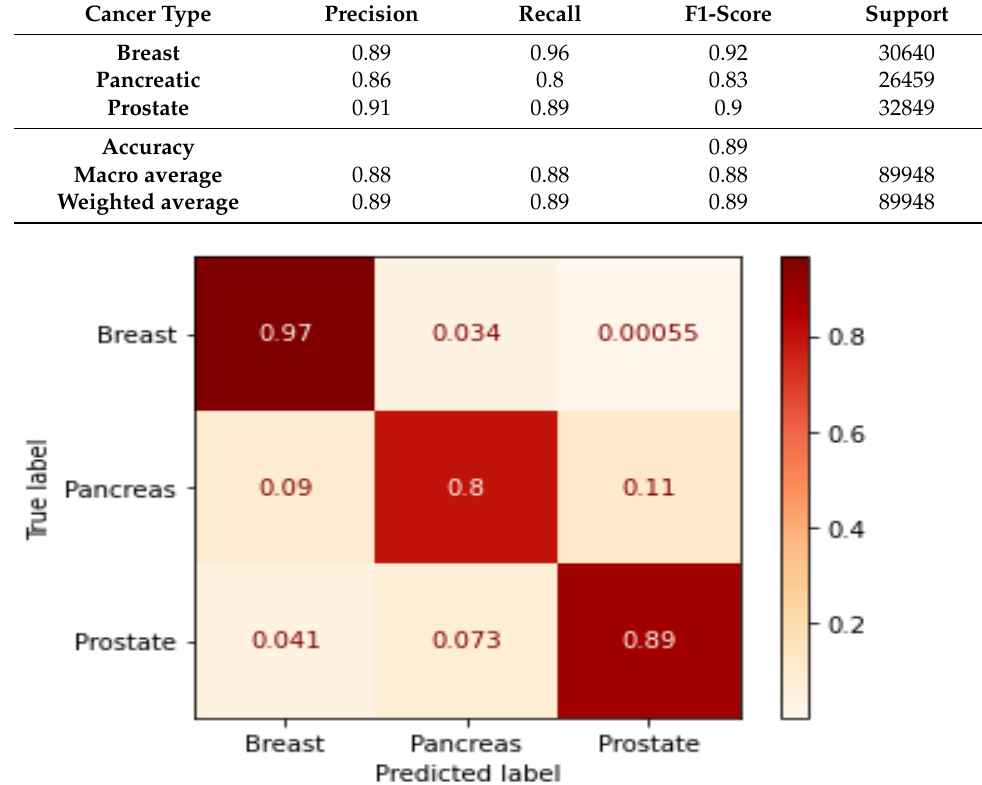
Figure 7. Confusion